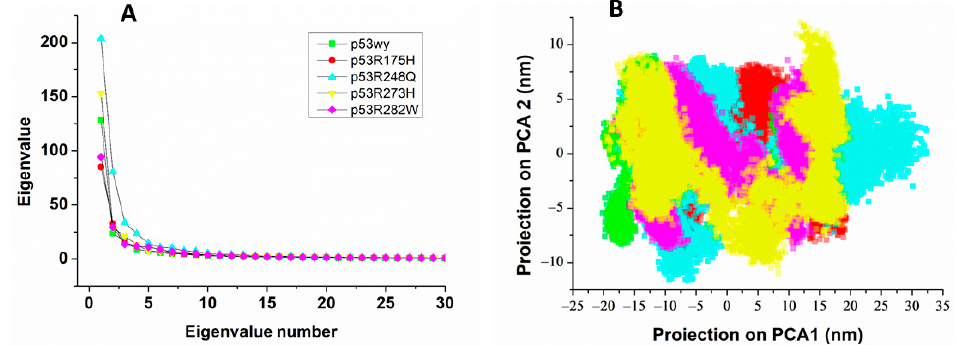
Figure 3. ( A ) Eigenvalues as a function of the eigenvalue number; ( B ) 2D-plot of projection of PC1 vs. the projection of PC2 for all the systems. Colors are the same as in Figure 1.